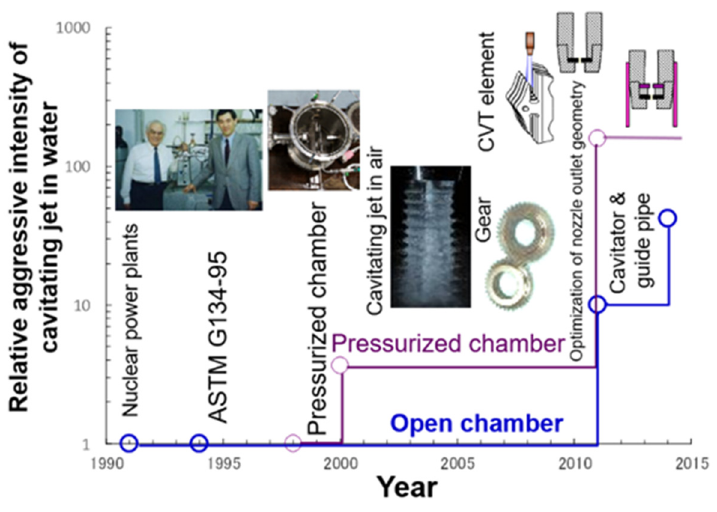
Figure 1. Development of relative aggressive intensity of cavitating jet, changing over time.